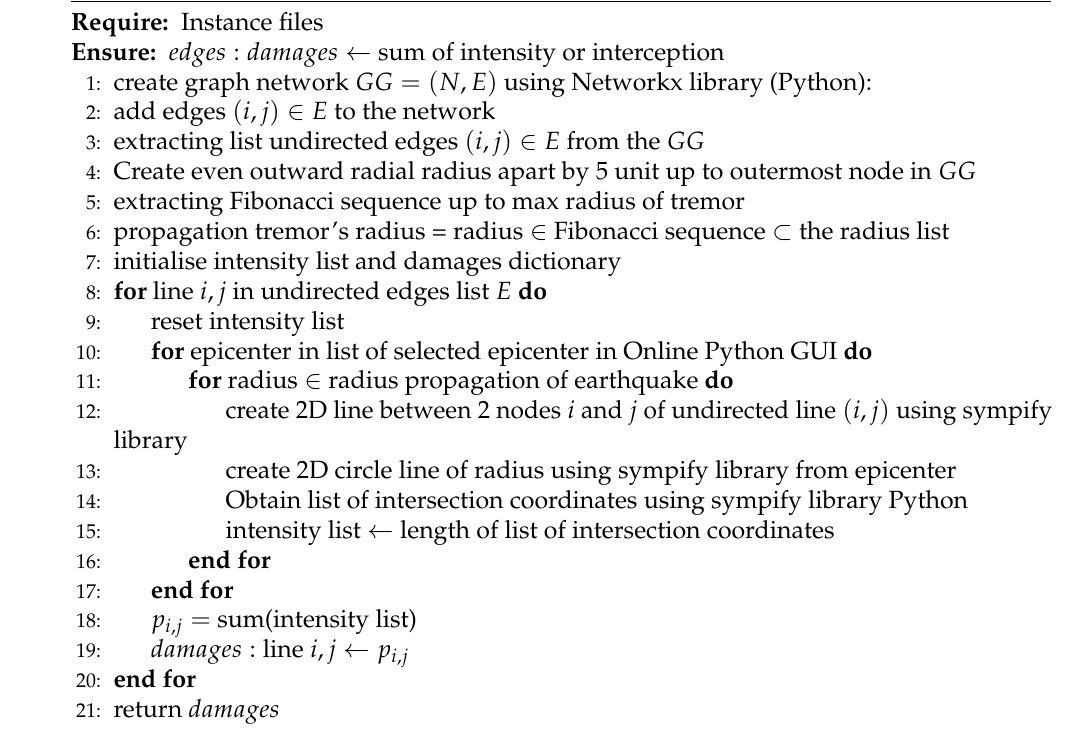
Figure 1. Damage Determination based on Interception on Edge due to Dispersion Radial Circle Representing Earthquake Tremor. Algorithm 1 shows how the radial dispersion could be simulated using Fibonacci’s numbers. Algorithm 1 Pseudocode for determining damages on all edges in road network